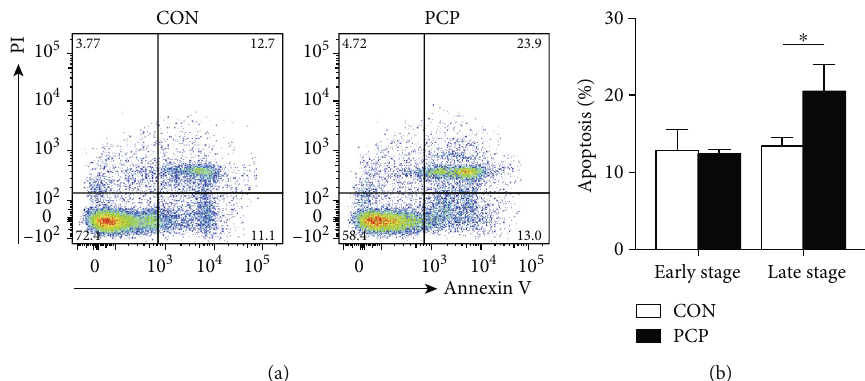
Figure 1: Apoptosis rate of primary B cells. B cells were extracted from the lung tissues of uninfected and Pneumocystis- infected mice (8 – 10 mice per group) using anti-CD19 MicroBeads. B cells were stained with Annexin V and PI. The proportion of apoptosis was assessed via fl ow cytometry. (a) Representative fl ow cytometric graph of B cell apoptosis. Annexin V + PI - staining represents early apoptosis, while Annexin V + PI + staining represents late apoptosis. (b) The comparison of early and late apoptotic percentage of B cells isolated from CON and PCP mice ( n = 3 ). ∗ p < 0 : 05 compared with the CON group by Student ’ s t test. CON: uninfected control mice; PCP: Pneumocystis pneumonia mice.